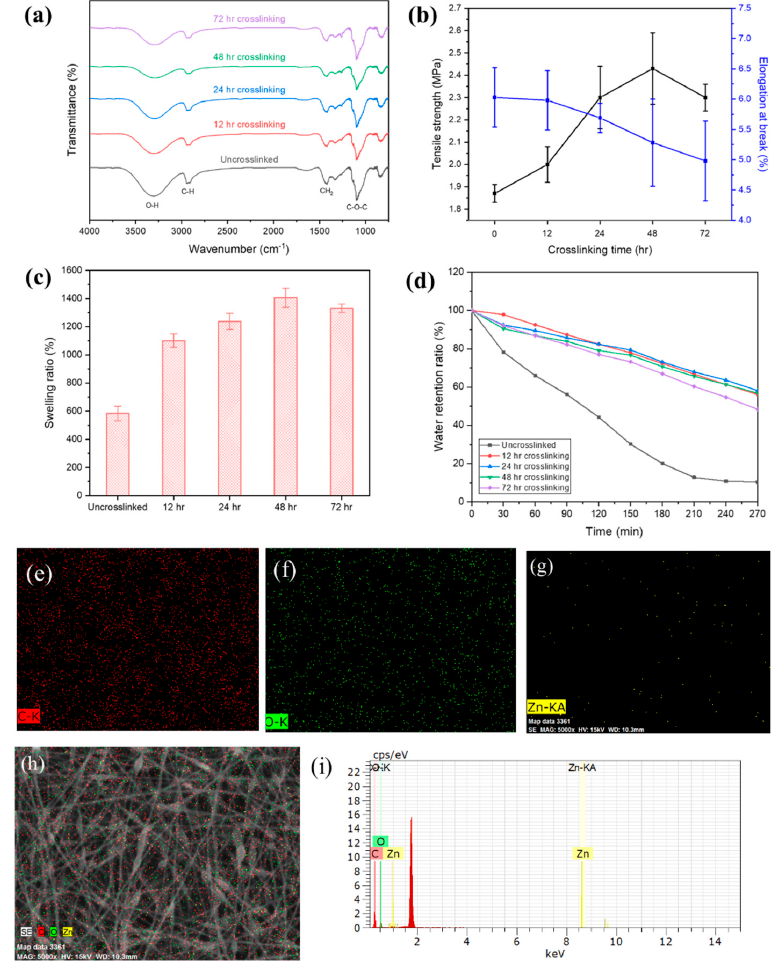
Figure 5. ( a ) The FTIR spectrum of PVA/SA/GO/ZnO nanofibers under different crosslinking time parameters. ( b ) Tensile strength and elongation at break of crosslinked GA-treated PVA/SA/GO/ZnO nanofibers. ( c ) The swelling ratio of GA-treated PVA/SA/GO/ZnO nanofibers within the time course. ( d ) GA-treated PVA/SA/GO/ZnO nanofibers’ water retention capacity rate with different cross-linking times. The EDS mapping of PVA/SA/GO/ZnO nanofibers via 12 h of GA vapor cross-linking reaction: ( e ) carbon, ( f ) oxygen, ( g ) zinc, ( h ) combination of the element mapping image (carbon, oxygen, and zinc) and SEM image and ( i ) the EDS spectrum.